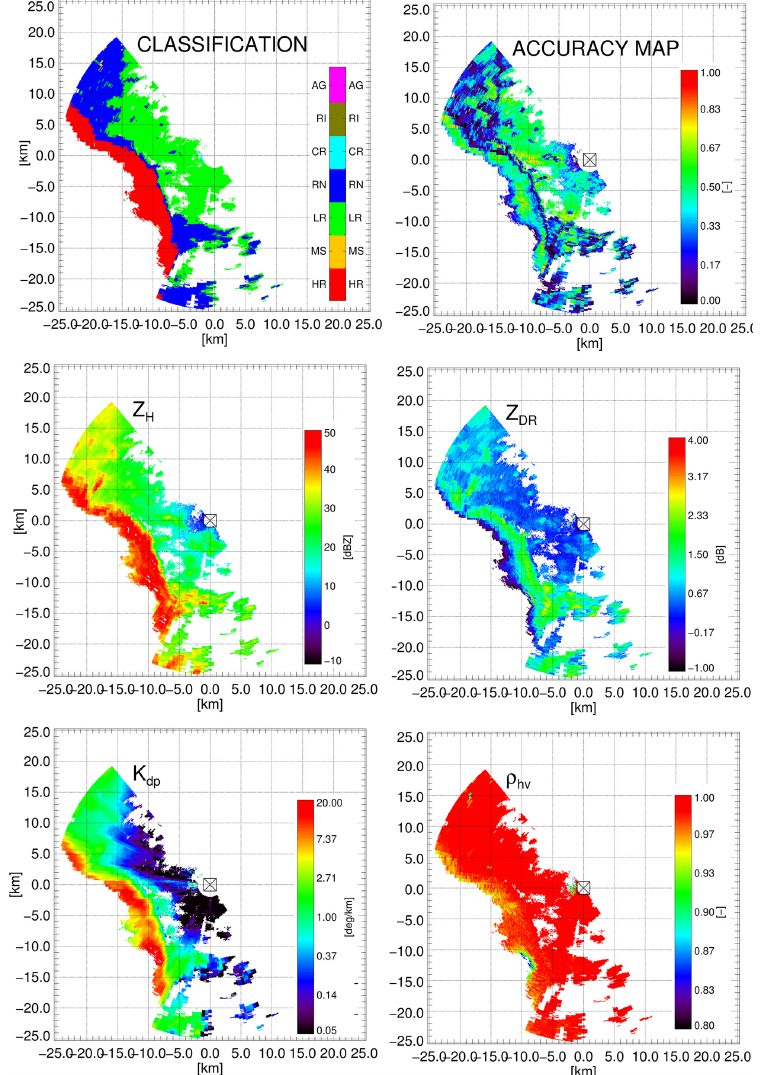
Figure 7. Hydrometeor classification and polarimetric observation from a PPI sector scan collected on the 24 September during HyMeX Special Observation Period (SOP) 2012 at 02:12UTC with an elevation angle of 3.5 ◦ . The different panels show the following variables: hydrometeor classification with the clustering approach, classification accuracy, Z H [dBZ], Z DR [dB], K dp [ ◦ km − 1 ], and ρ hv [–]. The spatial coordinates x and y originate at the radar